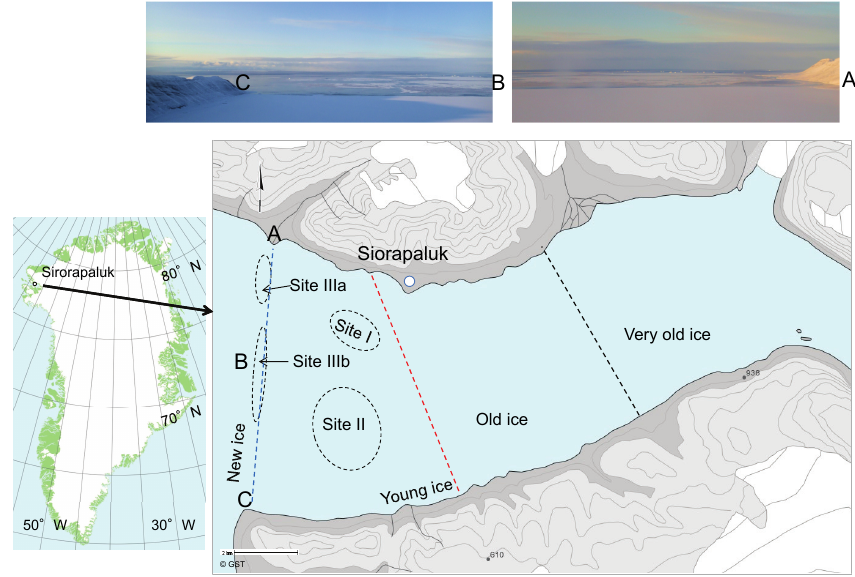
Figure 1. Locations of sampling and sea-ice conditions around Siorapaluk and photographs of new sea-ice conditions off Siorapaluk (taken from helicopter on 7 March 2014). Black, red, and blue dashed lines show locations of sea-ice break in November, 2013, and on 10– 14 February 2014 and 1 March 2014, respectively. The letters A, B, and C illustrate the general locations in the corresponding maps and